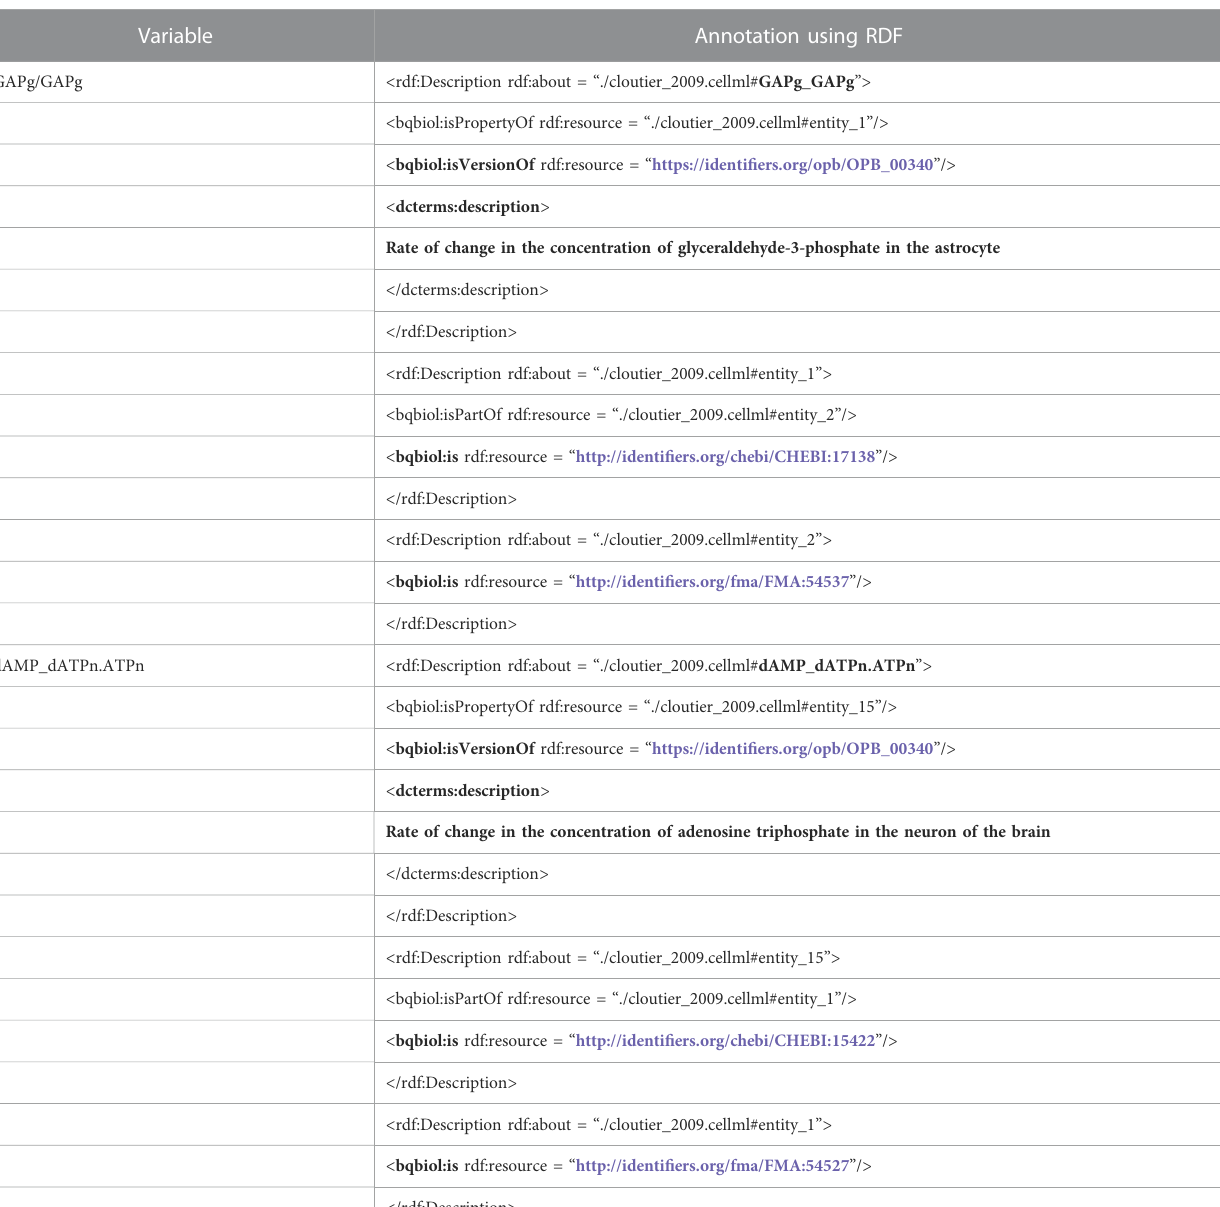
TABLE 1 The example of compositely annotated entities written using the RDF standard in the PMR. These entities are variables of the brain energy metabolism model,GAPg/GAPg and dAMP_dATPn.ATPn (Cloutier et al., 2009). They are described by ontology classes such as OPB_00340, CHEBI:17138, and FMA:54527; and predicates such as ‘ bqbiol:isVersionOf ’ and ‘ bqbiol:is ’ . There are also literal descriptions marked by the dcterms:description predicate, although not all entities have